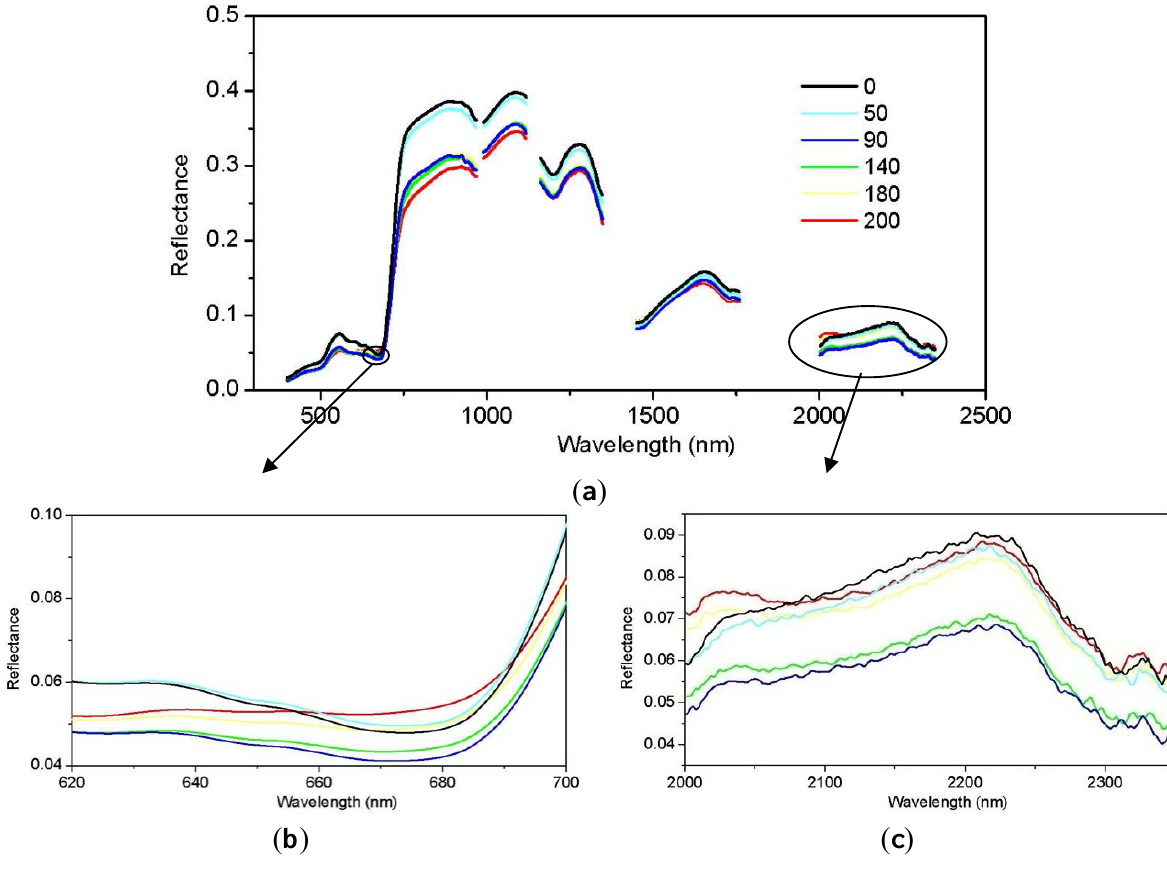
Figure 2. Juniper canopy spectral reflectance curves for variable cone densities (0, 50, 90, 140, 180, 200 g/m 2 ). Only six of the cone density levels are shown in order to more clearly depict the reflectance signature